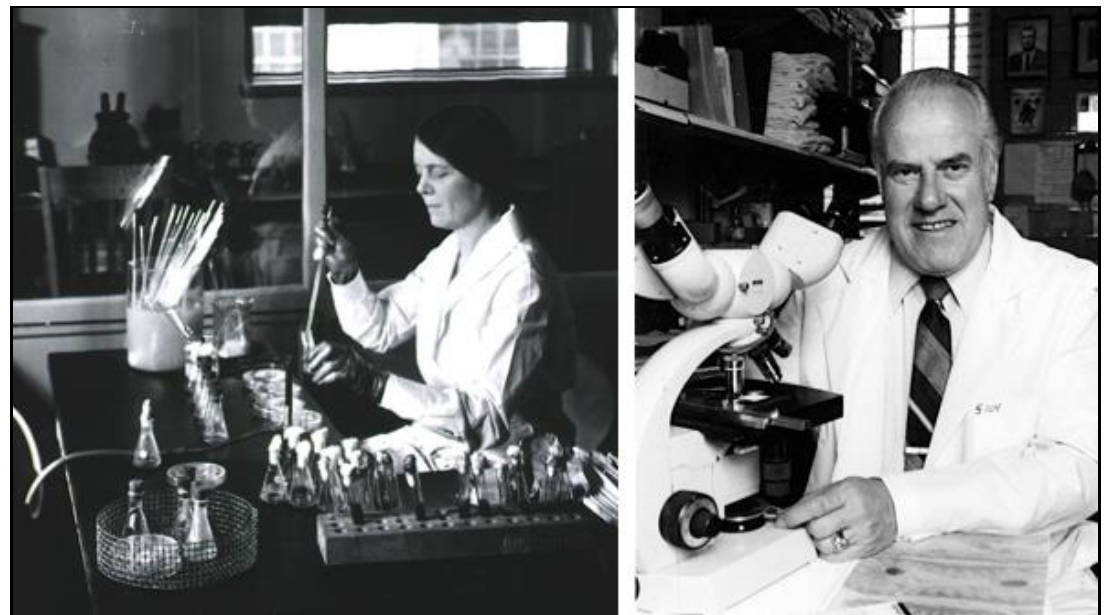
Figure 8. The Innovators. Left. Ida A. Bengtson PhD, the bacteriologist in the United States Public Health Service Hygienic Laboratory who developed the complement fixation serologic test for flea-borne typhus [128,129]. Right: Willy Burgdorfer PhD, director of the team at the Rocky Mountain Laboratory that developed the indirect fluorescent antibody serologic test for flea-borne typhus [134].